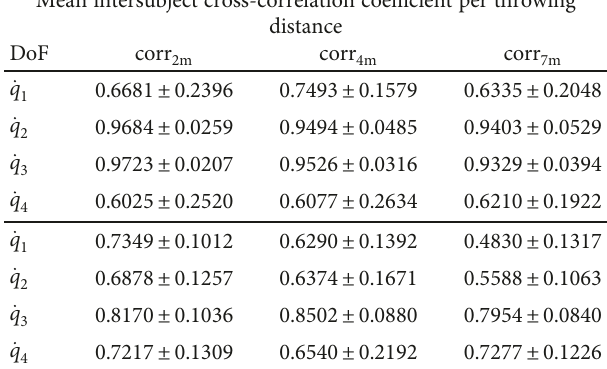
. These are the mean and standard deviation values of the features T ,All Table 2: Mean intersubject cross-correlation coe ffi cient per throwing